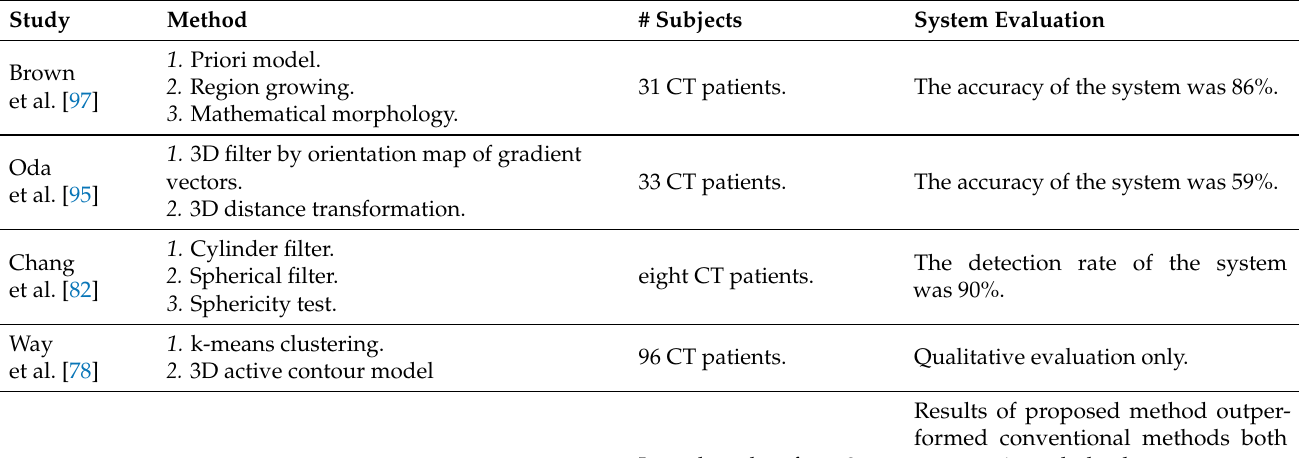
Table 2. Literature review of pulmonary nodule detection and segmentation